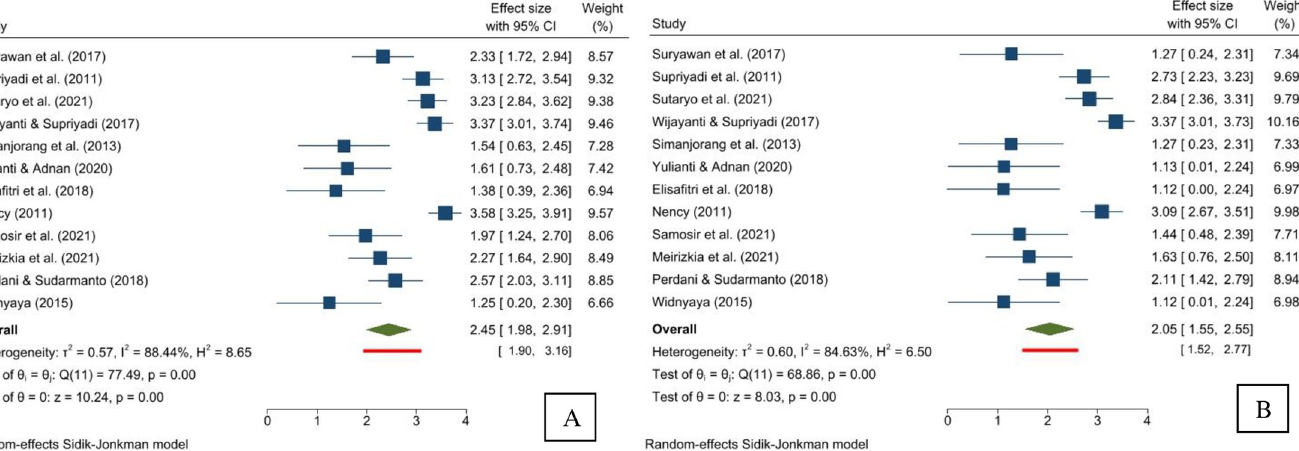
PLOS ONE | https://doi.org/10.1371/journal.pone.0269706 June 13,